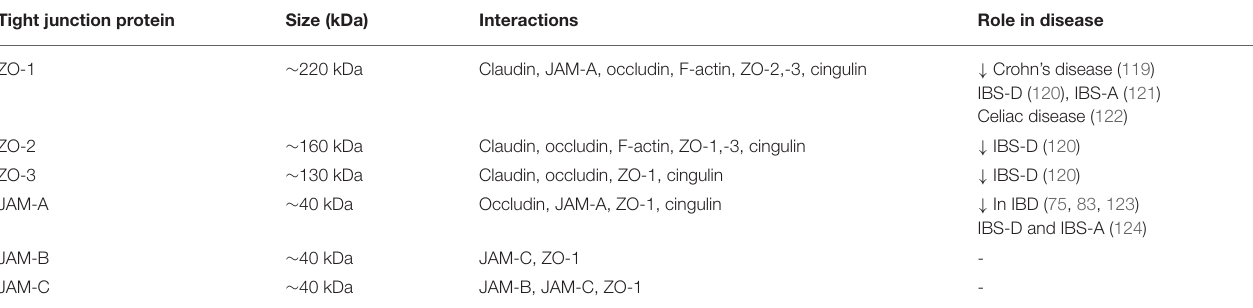
TABLE 2 | Characteristics of zonula occludens (ZO) proteins and junctional adhesion molecules (JAM) and their changes in intestinal diseases. Tight junction